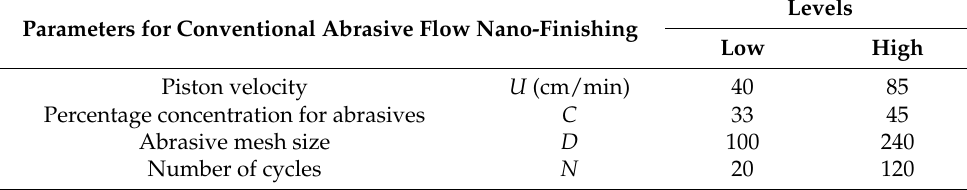
Table 1. Parameter design for the experiments [2].